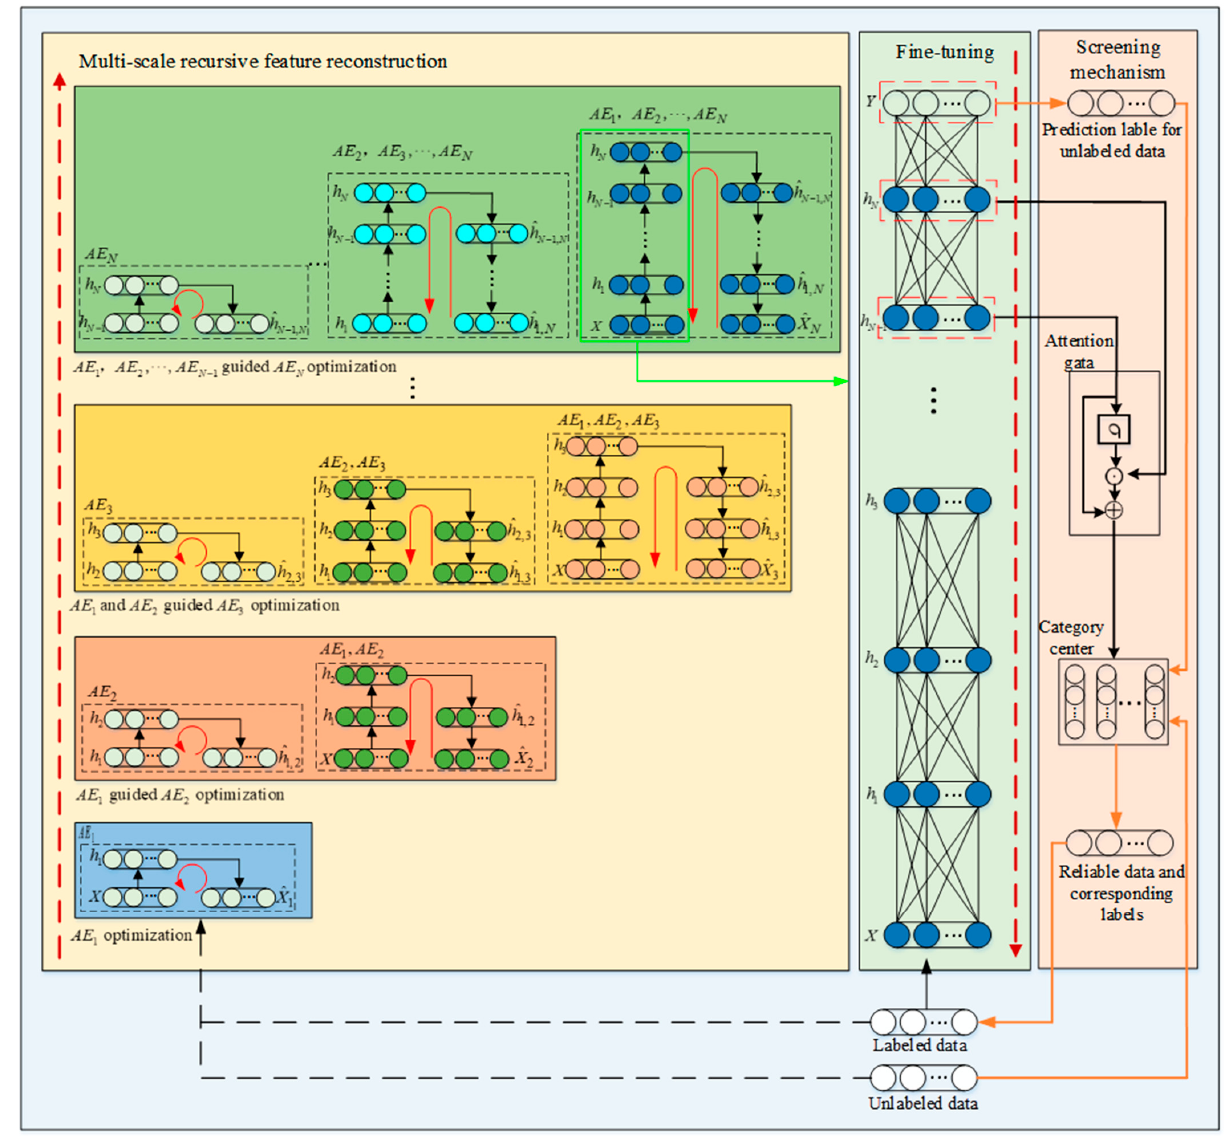
Figure 3. Schematic of the